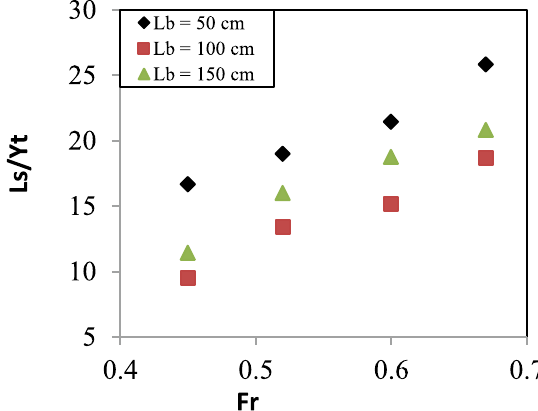
Fig. 4 Relationship between scour hole length to tail water depth L s /Y t and Fr at apron